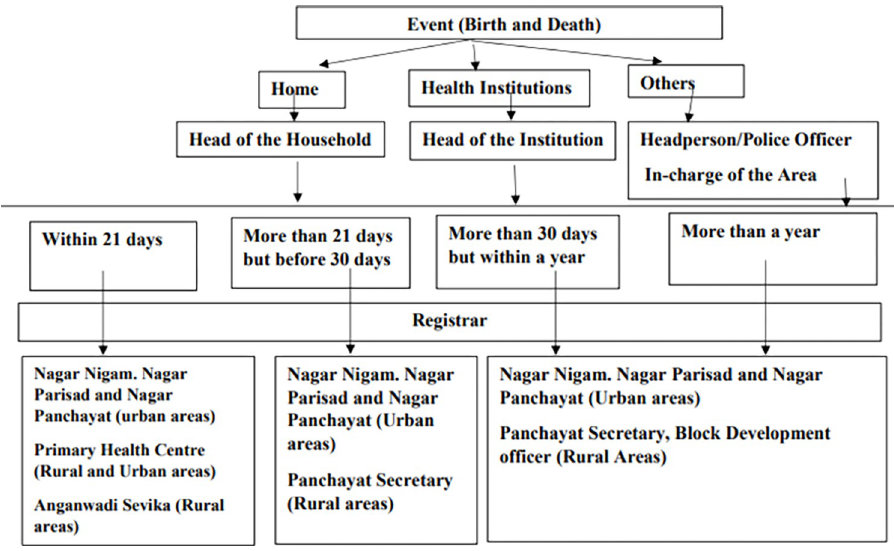
Fig 1. Flow chart of birth and death registration in Bihar. CRS annual report, 2020. Department of Planning and Development, Bihar, 2021. Note:- In case of birth and death registration after 30 days but within 1 year, registration is done after written permission of the prescribed authority and on the submission of an affidavit made before a notary public and payment of a late fee of rupee five (US$ 0.07). In case of registration of birth and death after an year, an order is required by a magistrate of the first class (Block Development Officer) after verifying the correctness of the event and payment a fee of rupee ten (US$ 0.14).